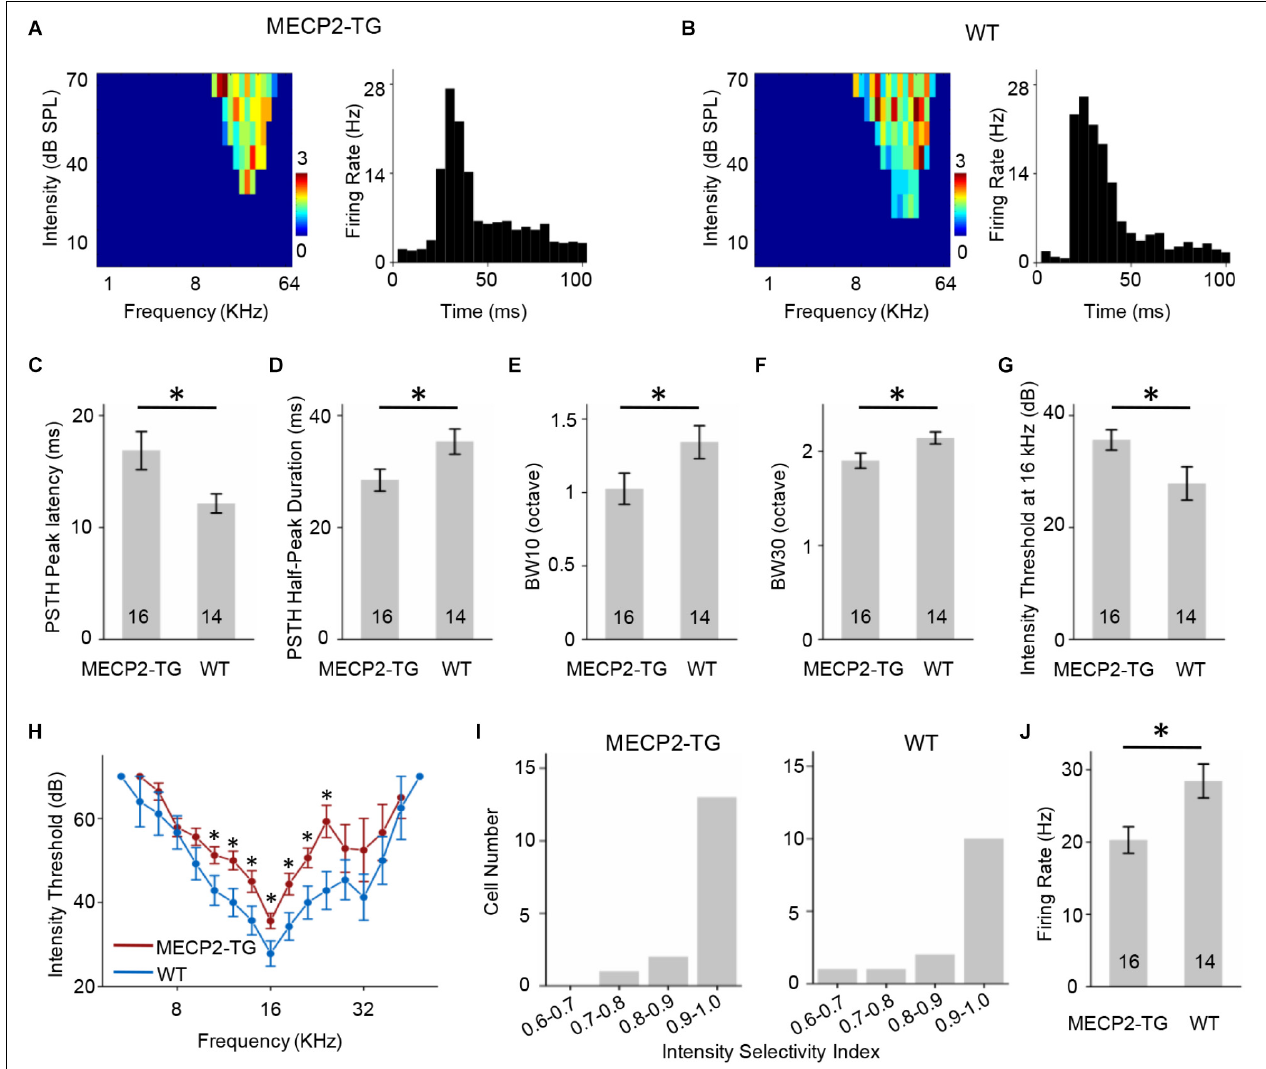
FIGURE 5 | (A,B) Left, representative tonal receptive fields (TRFs) of fast-spiking (FS) neurons. Right, representative peri-stimulus spike time histograms (PSTHs) of FS neurons. (C) Averaged peak latency of FS neurons recorded from MECP2-TG mice and wild-type (WT) mice. ∗ p < 0.05, t -test, mean ± standard error of the mean (SEM). (D) Averaged duration at the half-maximum level on the PSTHs of FS neurons recorded from MECP2-TG mice and WT mice. ∗ p < 0.05, t -test, mean ± SEM. (E,F) Average tuning bandwidth of TRFs at 10 dB and 30 dB above the intensity threshold in FS neurons recorded from MECP2-TG mice and WT mice. ∗ p < 0.05, t -test, mean ± SEM. (G) Average intensity threshold at the characteristic frequency (CF, 16 kHz) in FS neurons recorded from MECP2-TG mice and WT mice. ∗ p < 0.05, t -test, mean ± SEM. (H) Average intensity threshold for each frequency tested all along the tuning curve in FS neurons recorded from MECP2-TG mice and WT mice. (I) Distribution of intensity selectivity indices of FS neurons recorded from MECP2-TG mice and WT mice. Bin size = 0.1. (J) Averaged activity of FS neurons in response to the best frequency (BF) ± 0.2 octave at 70 dB. ∗ p < 0.05, t -test, mean ±